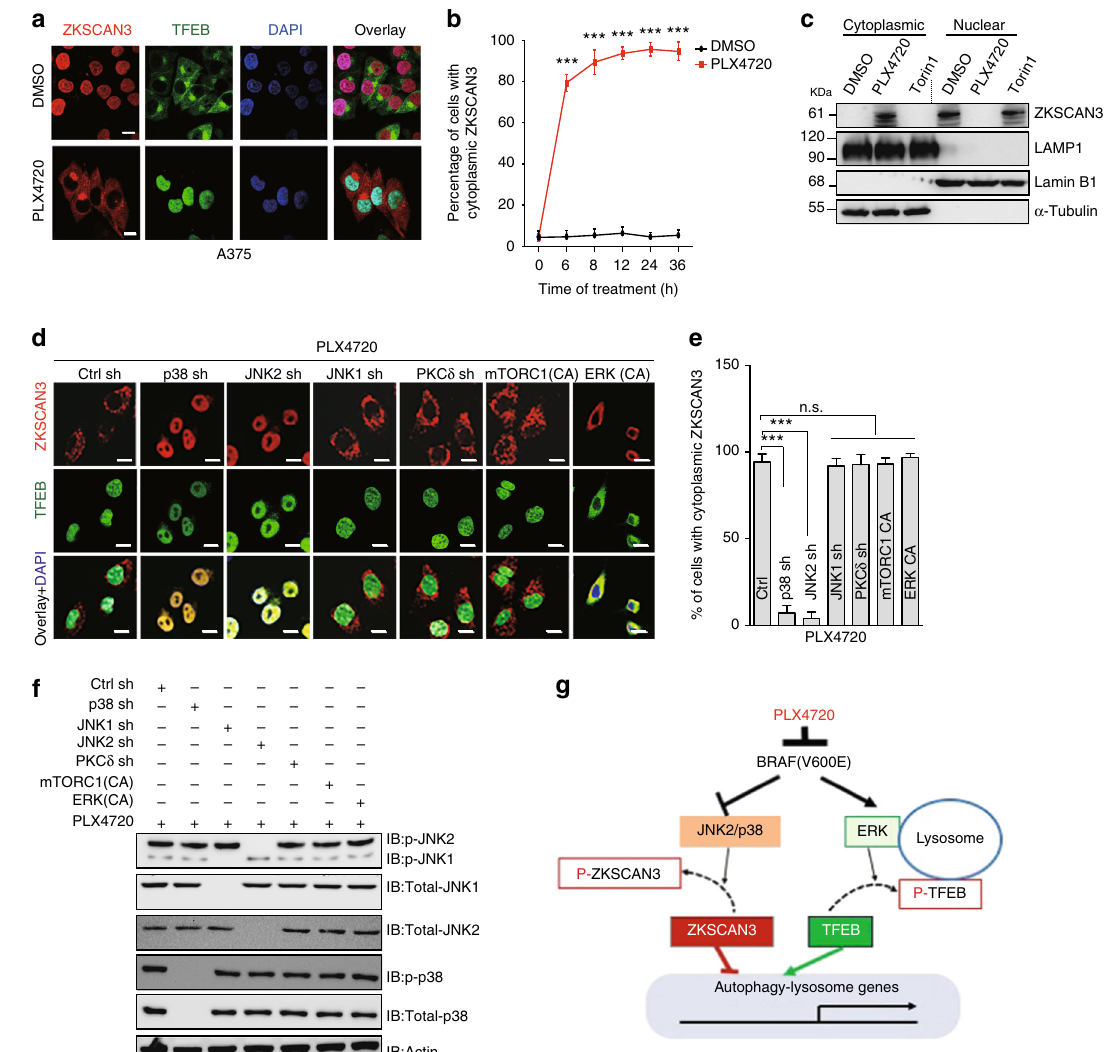
Fig. 4 PLX4720 induces JNK2/p38 MAPK-dependent cytoplasmic translocation of ZKSCAN3. a Representative confocal images of subcellular translocation of endogenous TFEB (green) and ZKSCAN3 (red) in A375 cells treated with PLX4720 (1 μ M, 12 h). n = 3 independent experiments. b Quanti fi cation of ZKSCAN3 cytoplasmic translocation in cells shown in ( a ). n = 150 cells per time point, pooled from three independent experiments. c Immunoblots for ZKSCAN3 in cytoplasmic and nuclear fractions of A375 cells treated with DMSO, PLX4720 (1 μ M, 12 h), or Torin1 (1 μ M, 3 h). Lamin B1 serves as the control for the nuclear fractions, whereas LAMP1 and Tubulin are the control of the cytoplasmic fractions. Note that PLX4720 induces cytoplasmic enrichment of ZKSCAN3, whereas Torin1 has no effect on its nucleocytoplasmic redistribution. d Effect of knockdown of p38, JNK1, JNK2, and PKC δ , or overexpression of the CA form of mTORC1 (E2419K) or ERK (R67S/D321N), on the subcellular translocation of endogenous TFEB (green) and ZKSCAN3 (red) in A375 cells treated with PLX4720 (1 μ M, 12 h). Nuclei were stained with DAPI (blue). n = 3 independent experiments. e , f Quanti fi cation of cytoplasmic translocation of ZKSCAN3 ( e ) and immunoblot analyses ( f ) of JNK1/2 and p38 in cells shown in ( d ). n = 3 independent experiments. g Schematic representation of the dual role of PLX4720 in the transcriptional activation of autophagy and lysosome biogenesis/function: PLX4720 induces TFEB nuclear translocation by inhibition of ERK, whereas also triggering ZKSCAN3 cytoplasmic relocation by activation of JNK2/p38 MAPK, leading to synergistically prolonged activation of the autophagy – lysosomal pathway. See the main text for the details. Scale bars, 10 μ m. Data in c and f are from one experiment that is representative of three independent experiments. For all quanti fi cation, data represent the mean ±SD derived from the indicated number of independent experiments. Comparisons were made using Student ’ s t -test. *** P < 0.001; n.s. not signi fi cant. See Supplementary Fig. 13 for uncropped data of c ,